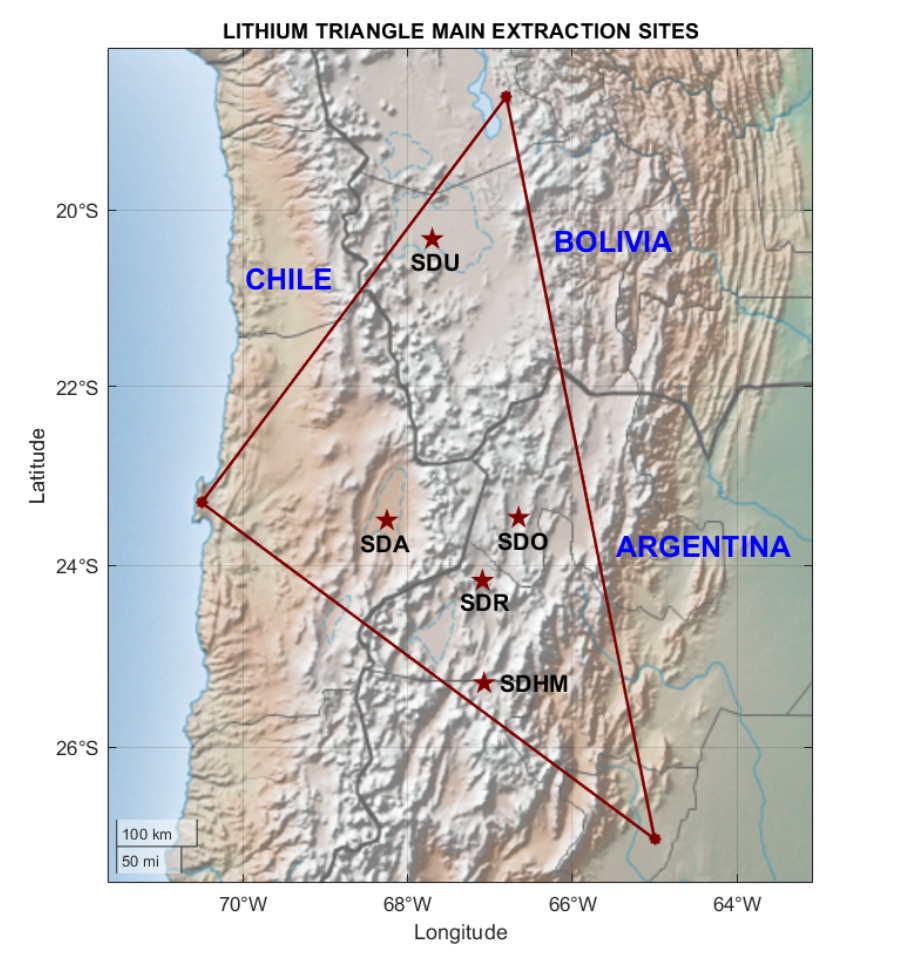
Figure 6. The South America’s lithium triangle holds the most important lithium extraction sites: Salar de Atacama (SDA), Salar del Hombre Muerto (SDHM), Salar de Uyuni (SDU), Salar de Olaroz (SDO), and Salar del Rincon